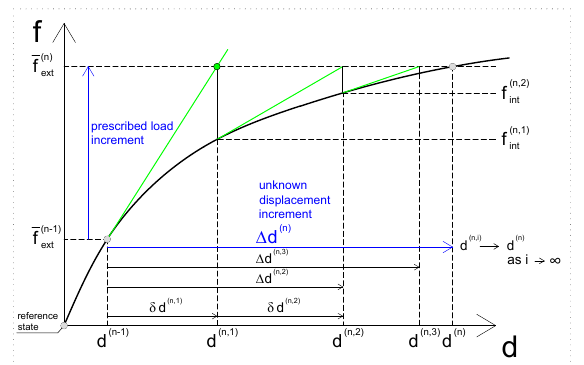
Figure 2. Newton - Raphson method.